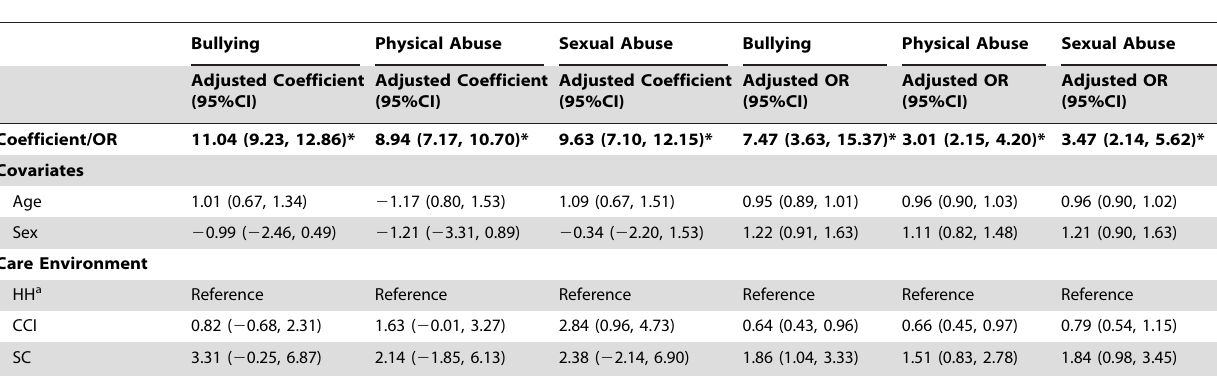
Table 4. Independent models adjusted for age, sex and care environment examining variation of PTSS median coefficient and PTSD with different